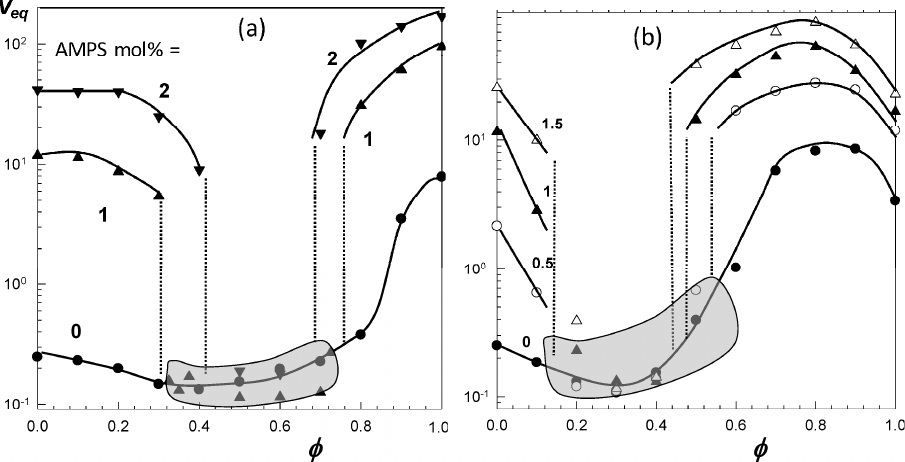
Figure 6. The volume V eq of TBA/AAm (60/40 by mole) hydrogel in water–DMSO ( a ) and water– ethanol mixtures ( b ) plotted against the cosolvent volume fraction φ in the solution. AMPS contents (in mol% of the monomers) are indicated. The shaded areas present the collapsed plateau. From [52] with permission from the Elsevier